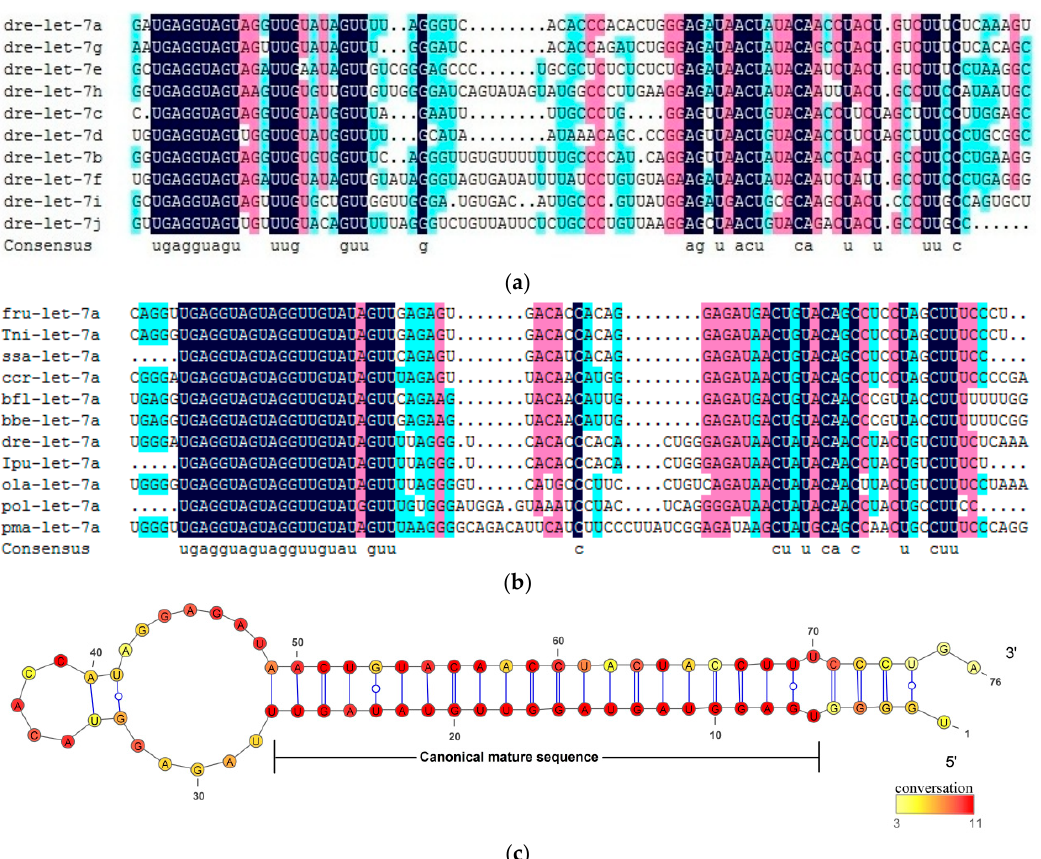
Figure 1. Sequence conservation in let-7 miRNAs. ( a ) Multiple sequence alignments of let-7 paralogs precursor sequences (5 ′ –3 ′ ); ( b ) Multiple sequence alignments of let-7a orthologs precursor sequences (5 ′ –3 ′ ); and ( c ) Consensus secondary structure of the let-7a precursor in fish, the position of canonical mature sequence produced have indicated the hairpin structure in let-7a precursors. Different colors represent the sequence conservation at single base for ( a , b ).